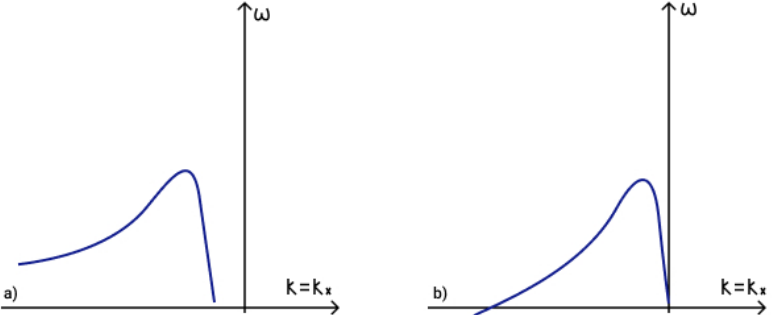
Figure 3. Dispersion curves of ( a ) hydrodynamic Rossby wave ω R and ( b ) hydrodynamic Rossby wave with correction due to stratification ω R + δ N